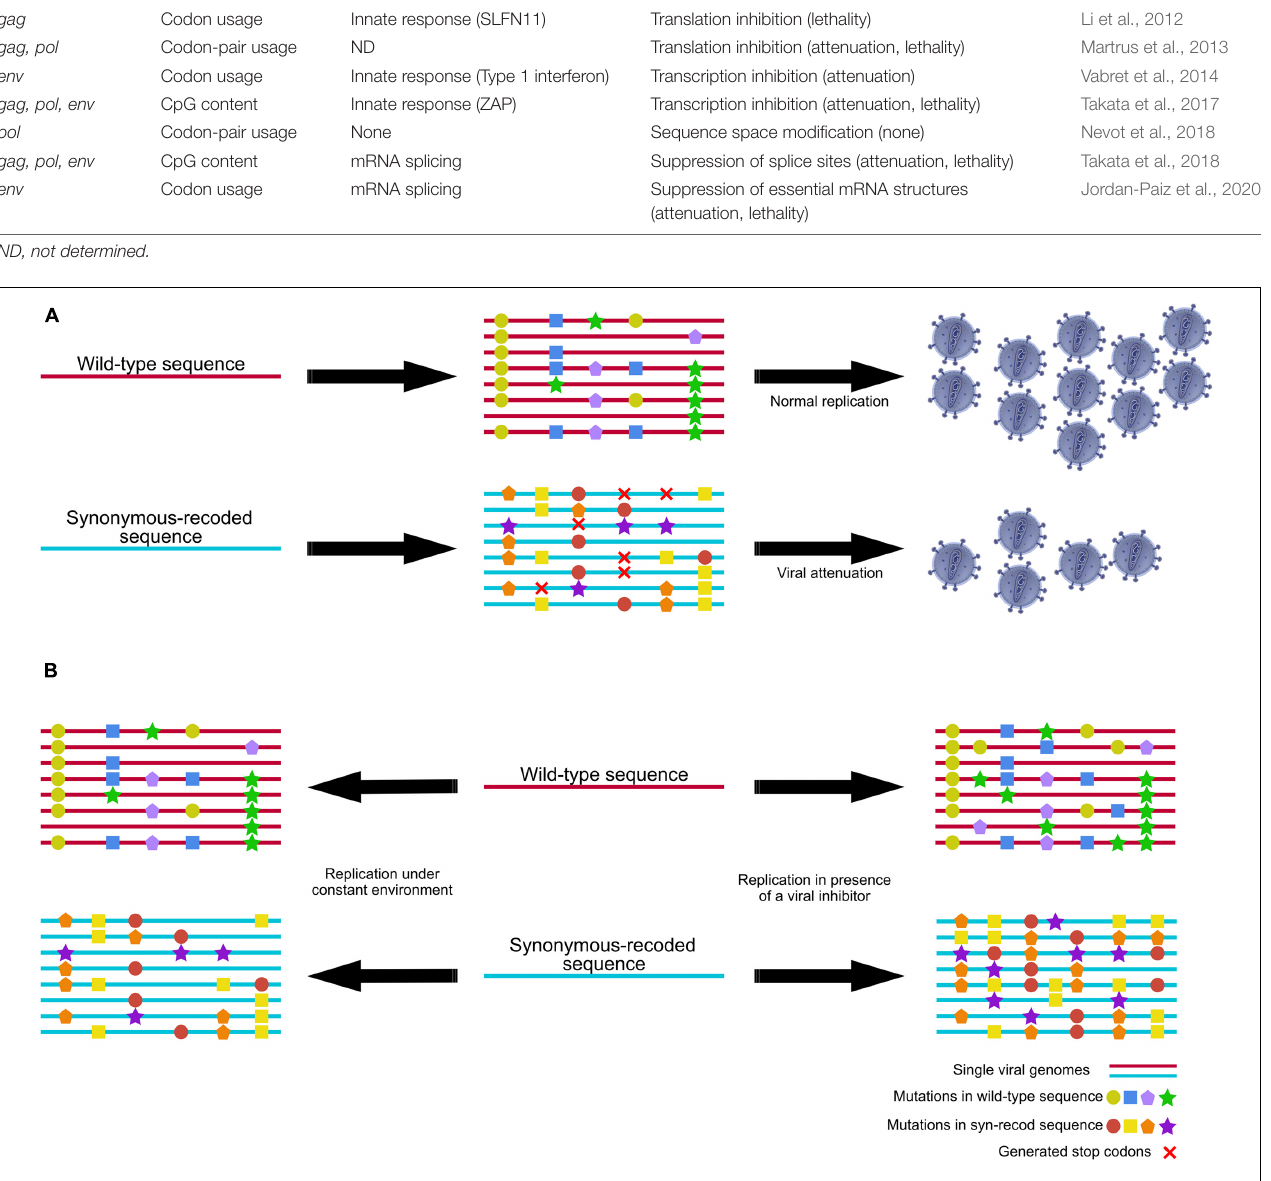
all candidates for new attenuated virus vaccines based on genome synonymous